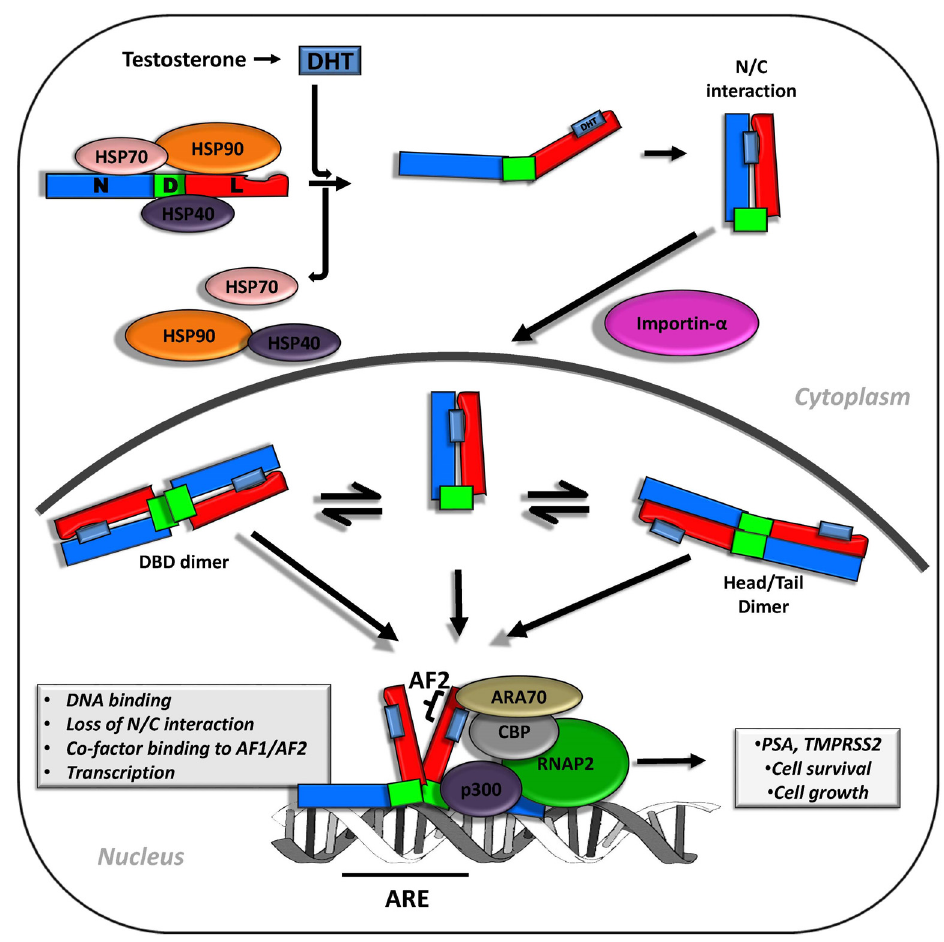
Figure 1. The androgen signaling pathway. The androgen receptor (AR) domains are labeled as: N— N -terminal domain (NTD); D—DNA binding (DBD); L—ligand binding domain (LBD). Locally produced dihydrotestosterone (DHT) interacts with the androgen receptor to facilitate release of heat shock proteins (HSP), N/C dimerization and exposure of a nuclear localization signal (NLS) required for interaction with importin- α and nuclear translocation. Inside the nucleus, the AR exists in equilibrium between monomers and dimers. Although it is unclear which form(s) are required for DNA binding, the AR exists as a dimer when bound to androgen response elements (AREs). DNA binding causes the N/C interactions to be lost, allowing the recruitment of transcription initiation and bridging factors, such as CREB binding protein (CBP), the transcription activator p300 and the AR-associated protein 70 (ARA70) to the AR. RNA-Polymerase II (RNAP2) can then transcribe AR-dependent